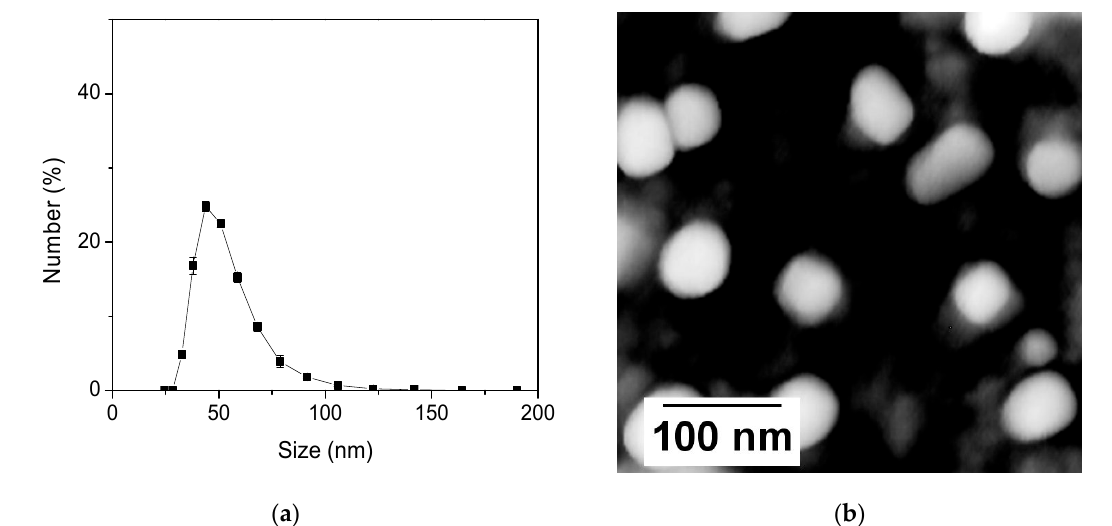
Figure 1. ( a ) Dynamic Light Scattering (DLS) measurements of the particle size distribution and ( b ) Atomic Force Microscopy (AFM) of nanosensors.